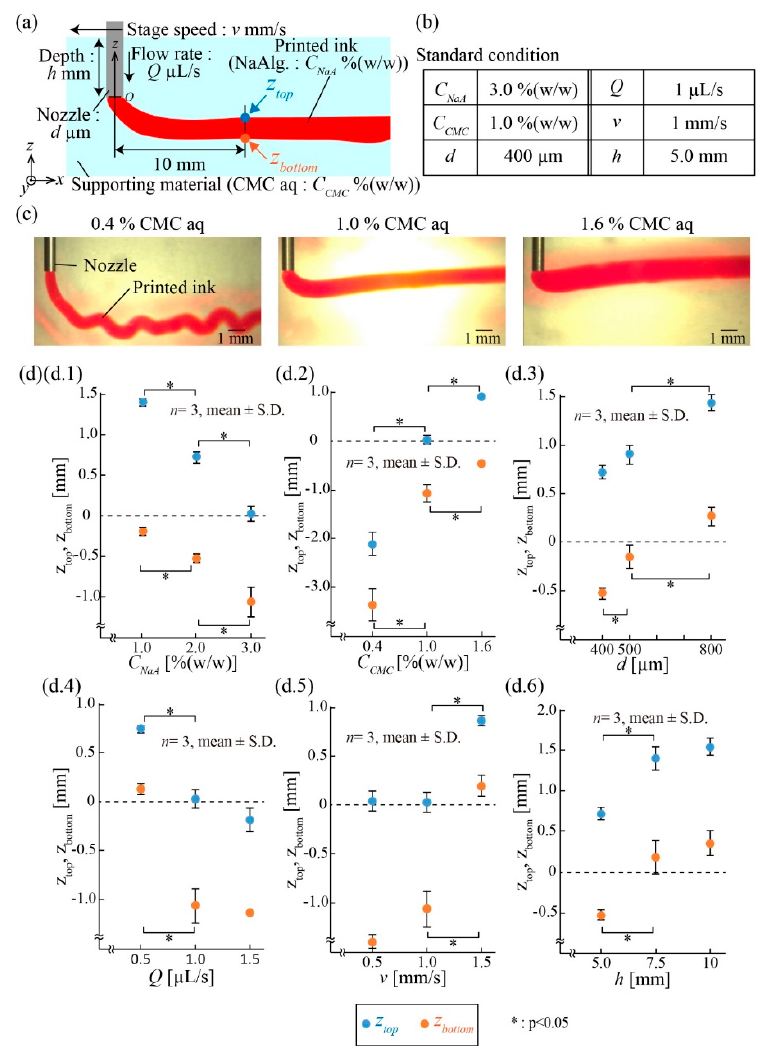
Figure 3. Measurement of the position of the printed ink in the supporting viscous liquid. ( a ) Schematic of z top and z bottom for the printed ink and parameters. ( b ) Table of the standard conditions. ( c ) Images of the printed ink with various concentrations of CMC aq. The z top and z bottom increased when the concentration of CMC aq increased. ( d ) The z top and z bottom for the printed ink under various conditions. The dotted line shows the position of the tip of the nozzle. Table 2. Value of the all parameters.